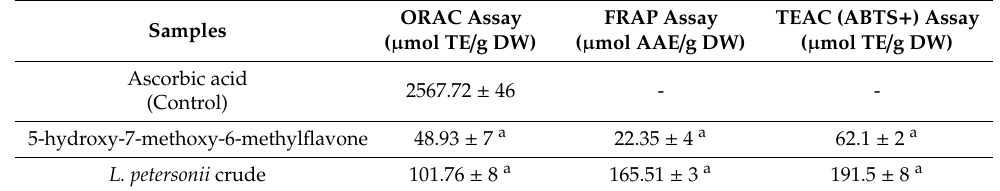
Table 2. Total Antioxidant Capacities of 5-hydroxy-7-methoxy-6methylflavone and L. petersonii Crude Extract.